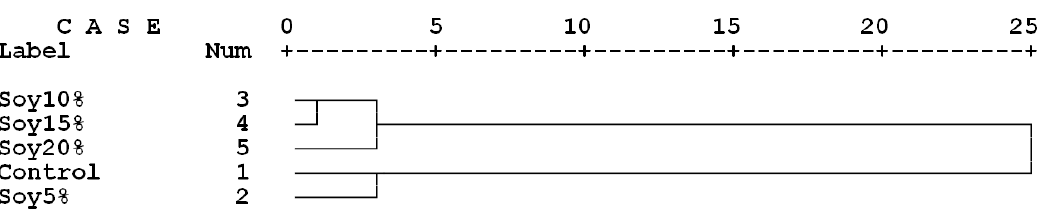
Figure 5. Shear strength (MPa) in three-layer plywood panels produced with urea-formaldehyde Figure 6. Cluster analysis of five different three-layer plywood panels produced with urea- resin and 5%, 10%, 15%, and 20% soy flour substitution of UF resin. formaldehyde resin, and 5%, 10%, 15%, and 20% soy flour substitution for UF resin (Soy% = soy flour content).